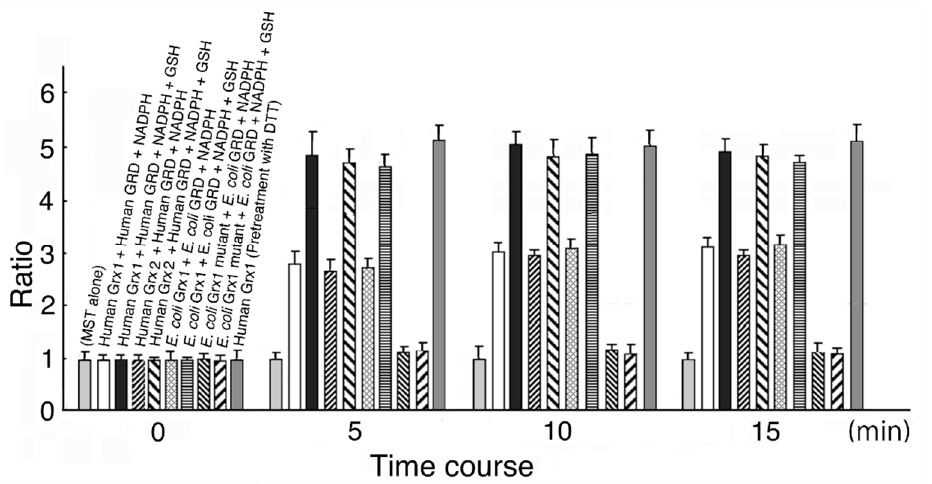
Figure 1. Time-dependent MST activation. The MST reducing system contains Grx, GSH, GRD, and NADPH. Each system was incubated at 20 °C for 0, 5, 10, and 15 min. Details are described in the text.